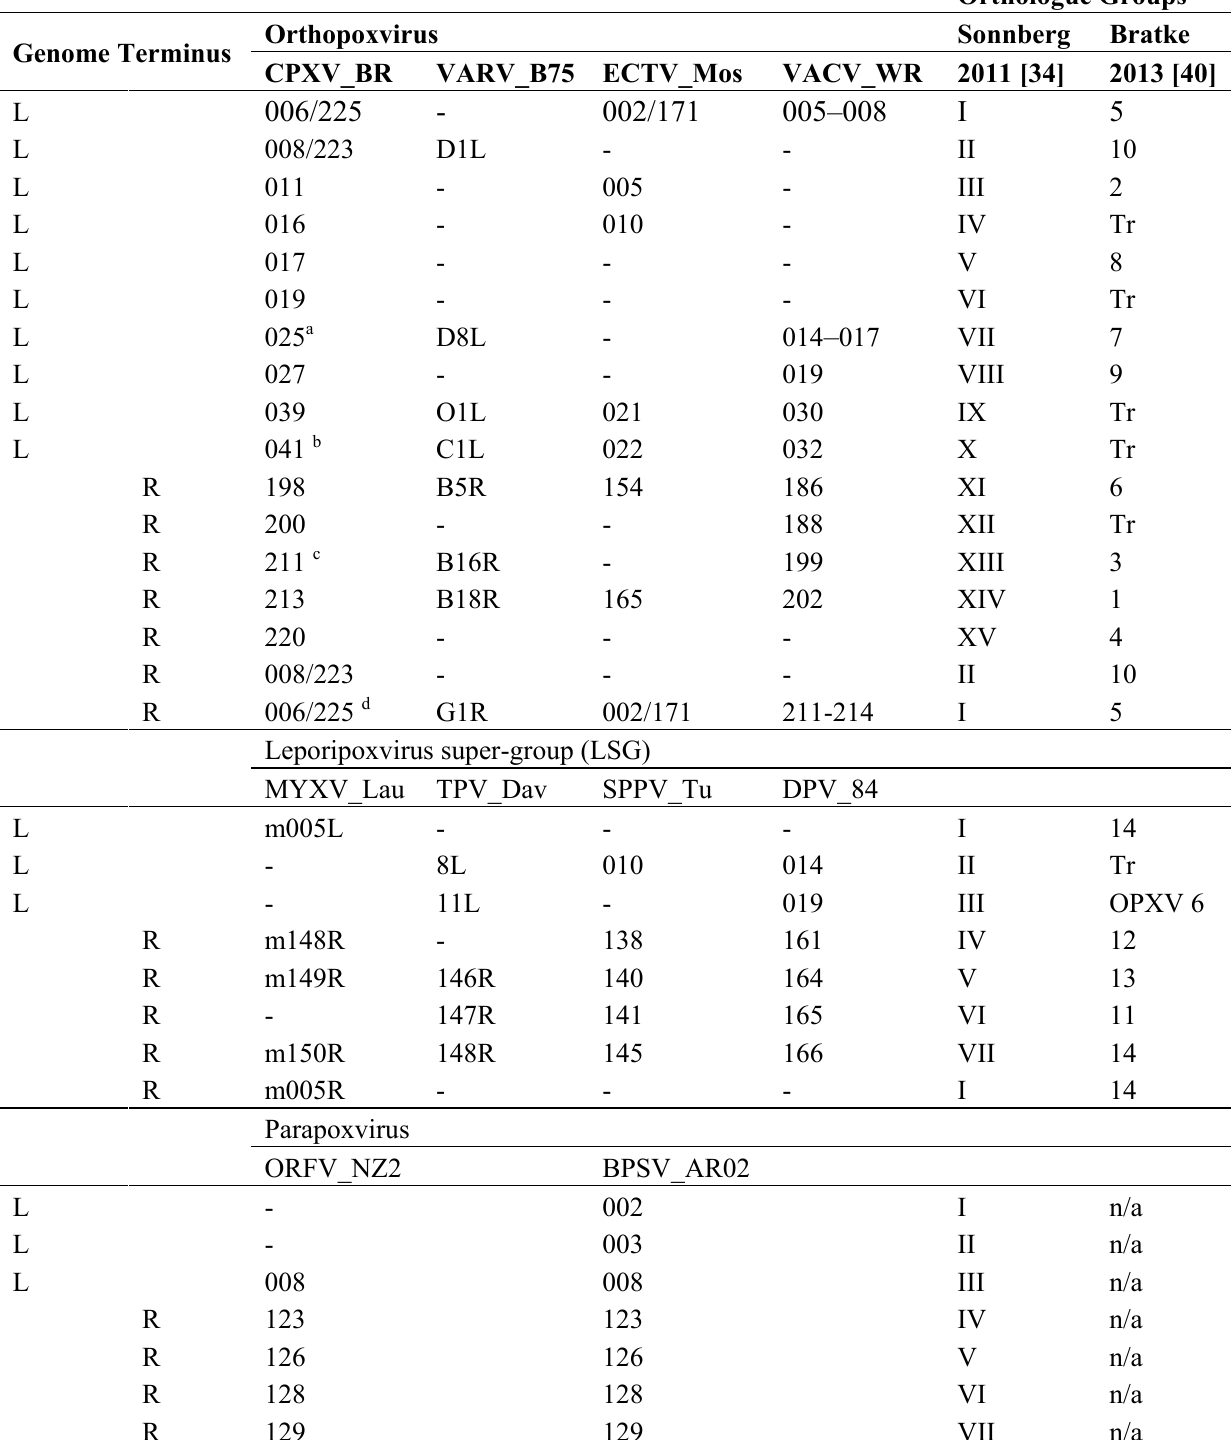
Table 2. Orthologue groups of poxviral ANK repeat proteins of key species and strains. Location and identity of ANK repeat genes in genomic termini (L, left, R right) are shown, with truncated or disrupted genes in grey (Tr). Protein orthologue groups are based on Sonnberg, et al. (2011) [34] and Bratke, et al. (2013) [40]. Well-studied proteins or homologues are indicated: a CWPX-CP77, b VACV-K1L, c VACV-68k, d VARV-G1R. ANK Repeat Poxvirus Genus, Species_Strain, and Location for ANK Repeat Genes